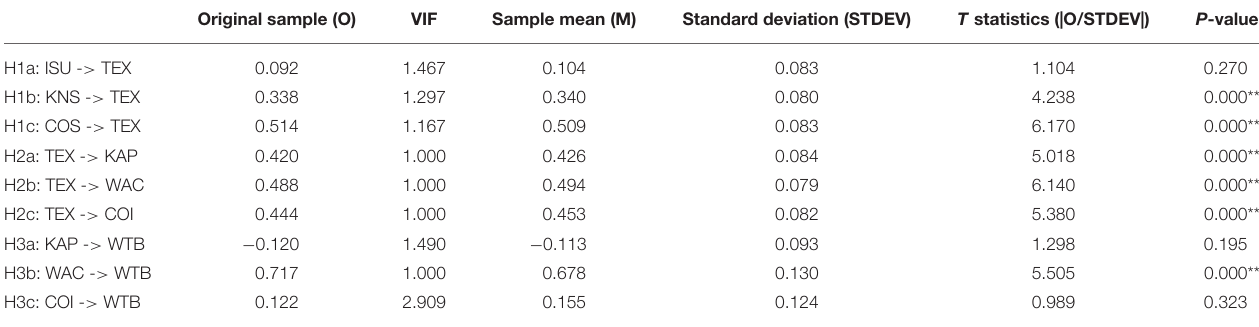
TABLE 2 | Evaluation of the structural model. Original sample (O) VIF Sample mean (M) Standard deviation (STDEV) T statistics (|O/STDEV|) P